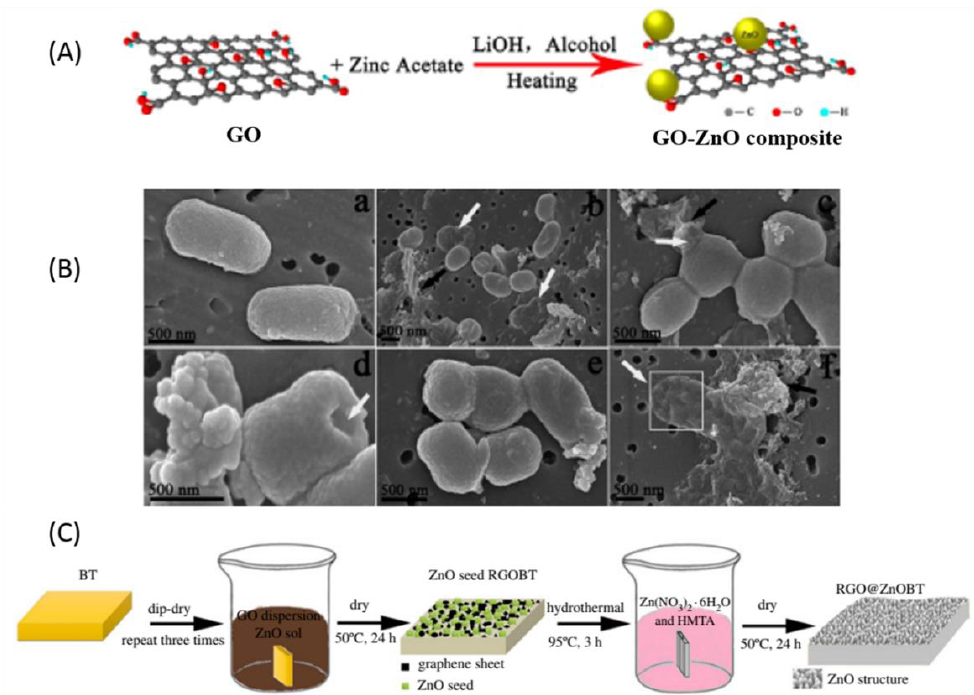
Figure 3. ( A ) Synthetic procedure for GO-ZnO composites from GO nanosheets. Reproduced from Reference [152] , with permission from American Chemical Society, 2014. ( B ) SEM images of E. coli: control ( a ) treated with GO-ZnO-1 for 24 hours ( b − d ), and treated with GO-ZnO-2 for 24 hours ( e , f ). Reproduced from Reference [152] , with permission from American Chemical Society, 2014. White square: cytoplasm leakage. Black arrows: GO-ZnO composites. White arrows: broken E. coli. ( C ) Schematic illustration of the synthetic procedure of RGO@ZnOBT [157] .